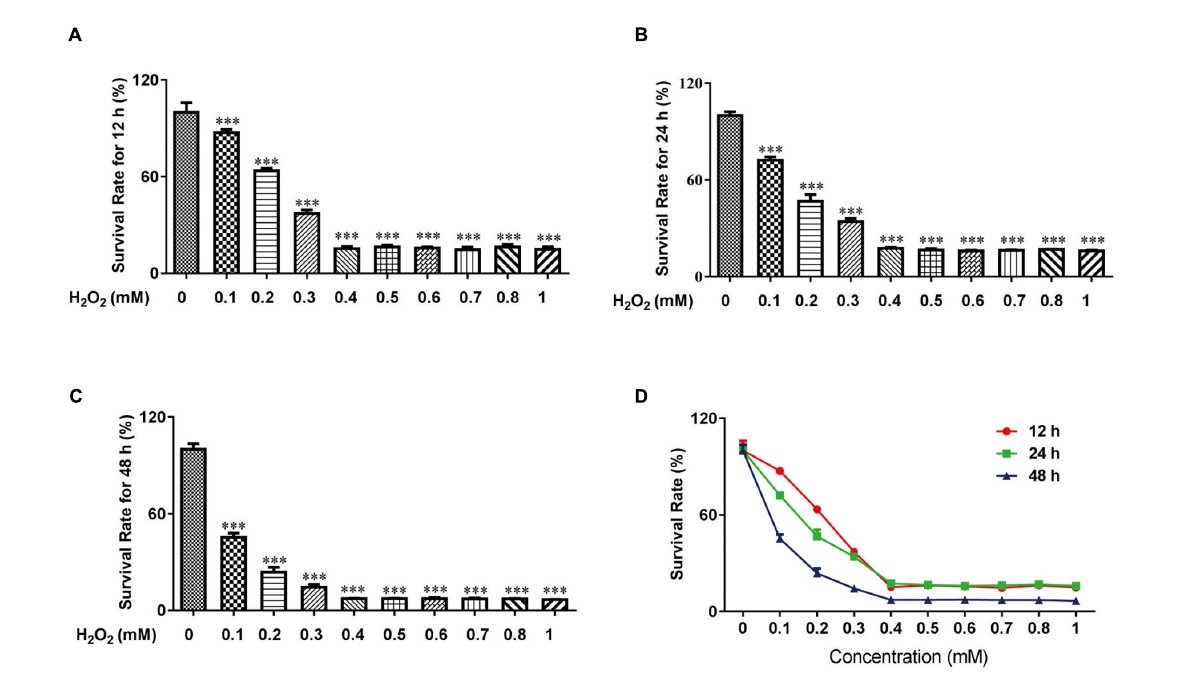
FIGURE1 H 2 O 2 caused oxidative stress damage in HTR-8/SVneo cells. The survival rate of HTR-8/SVneo cells after being treated with different doses of